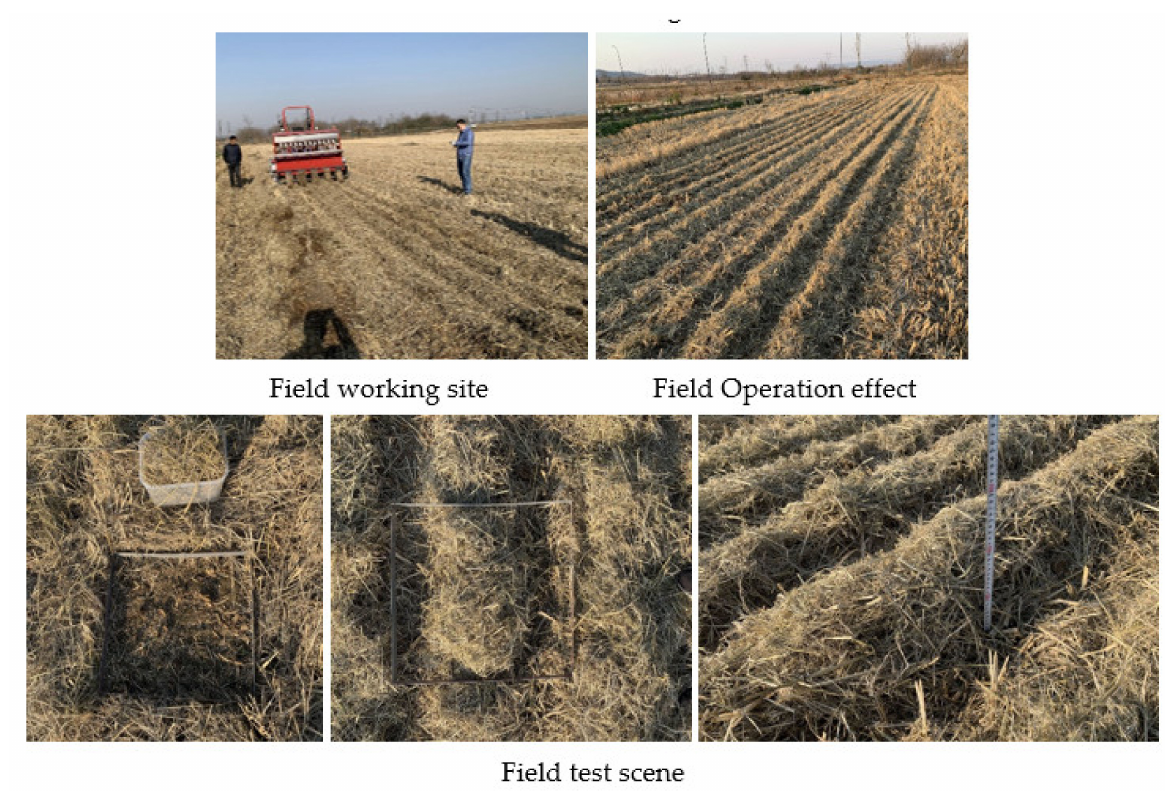
Figure 8. Picture of field validation and test